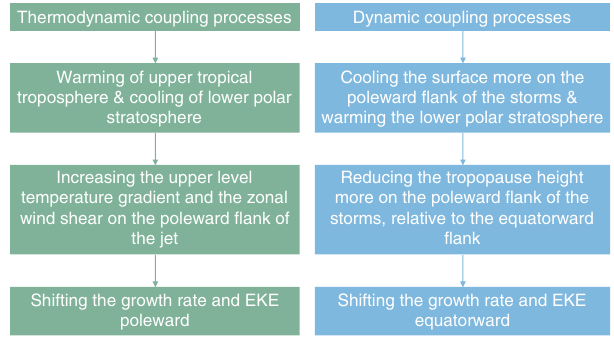
Fig. 5 Summary of the mechanisms underlying the latitudinal shift of mid-latitude eddy kinetic energy via ocean coupling processes. The fl owcharts show via which processes thermodynamic (in green) and dynamic (in blue) ocean coupling affect the position of mid-latitude storm shear vs. changes in tropopause height (see also Fig. 5 for a